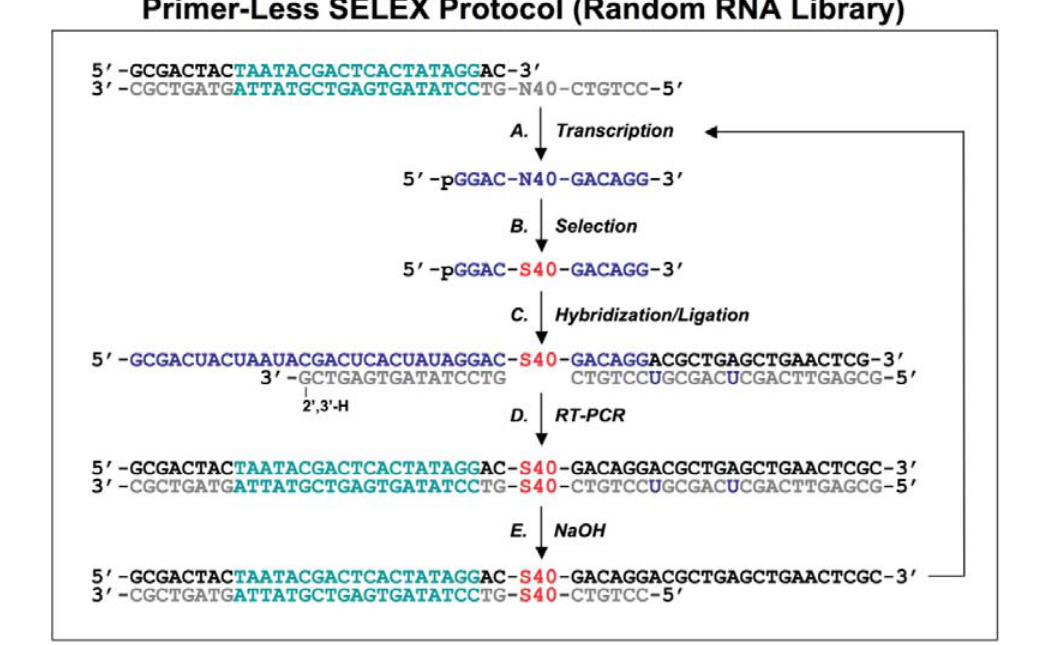
Figure 5 . Diagram of primer-less random RNA SELEX. The in vitro transcription templates are generated by annealing 2 oligonucleotides together, in which a portion of the templates is T7 RNA polymerase promoter (shown in green). The starting RNA library (blue) is transcribed (A) and selected by incubation with target protein (B), and then the selected RNA sequences are ligated with 5’ and 3’ duplexes (C) and RT-PCR amplified with 5’ primer containing a T7 promoter and 3’ primer containing a 2’ ribose (indicated in blue; D). The amplified products are subjected to alkaline hydrolysis to generate the transcription templates for the next round of selection. This protocol depicts that described by Vater et al.